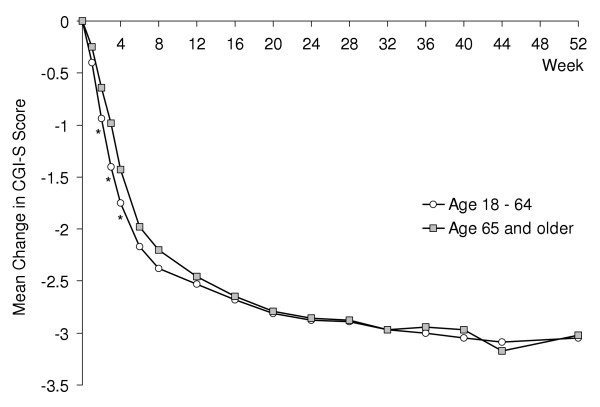
Comparison of mean change in CGI-Severity score for duloxetine-treated patients aged ≥ 65 years (n = 98) and age 18–64 years (n = 1121). * p ≤ .05 for between-group comparison.